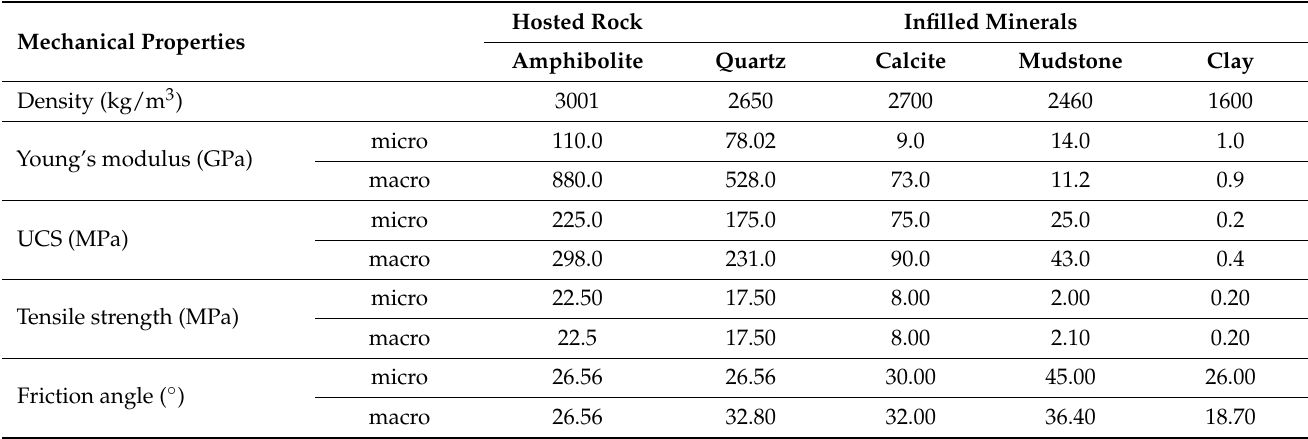
Table 1. Micro- and macro-mechanical properties of the hosted rock and infilled minerals.